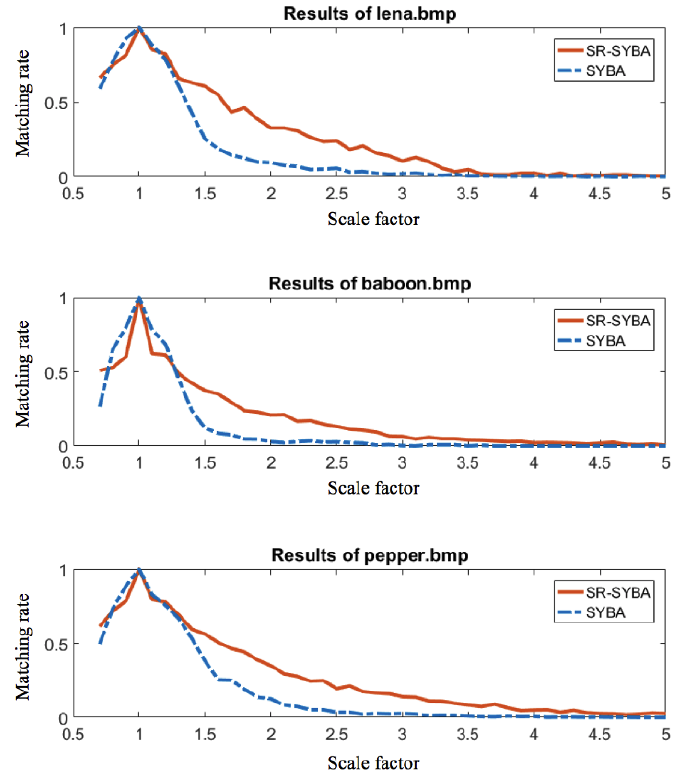
Figure 11. Matching rate comparison between SR-SYBA and SYBA with scaling variations.